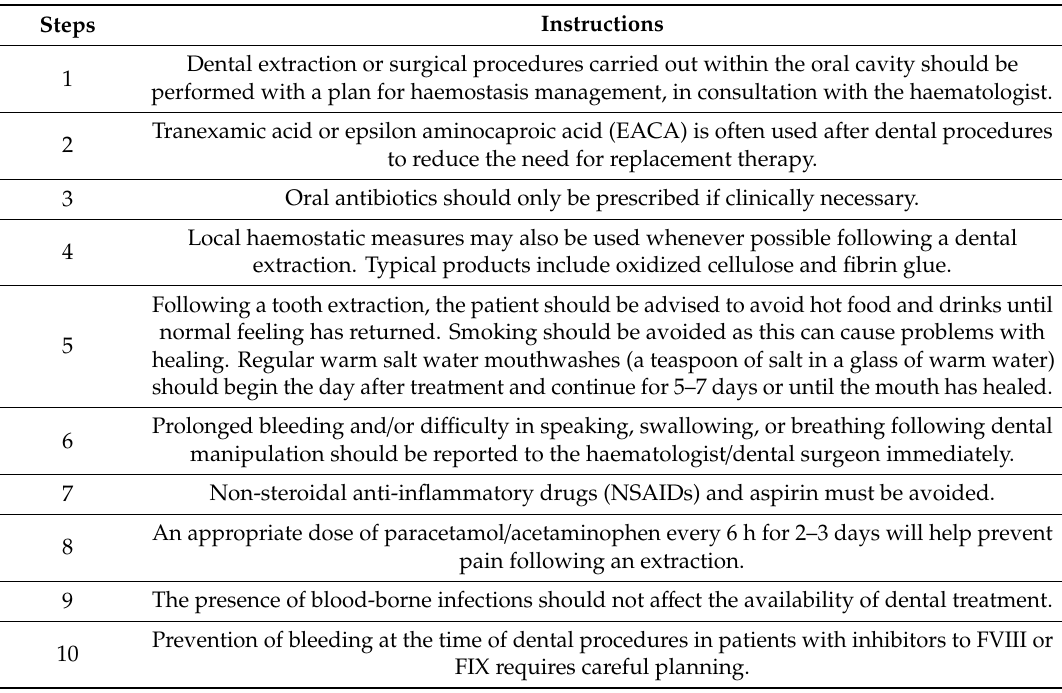
Table 2. Nelson et al. [43] Surgical teeth extraction